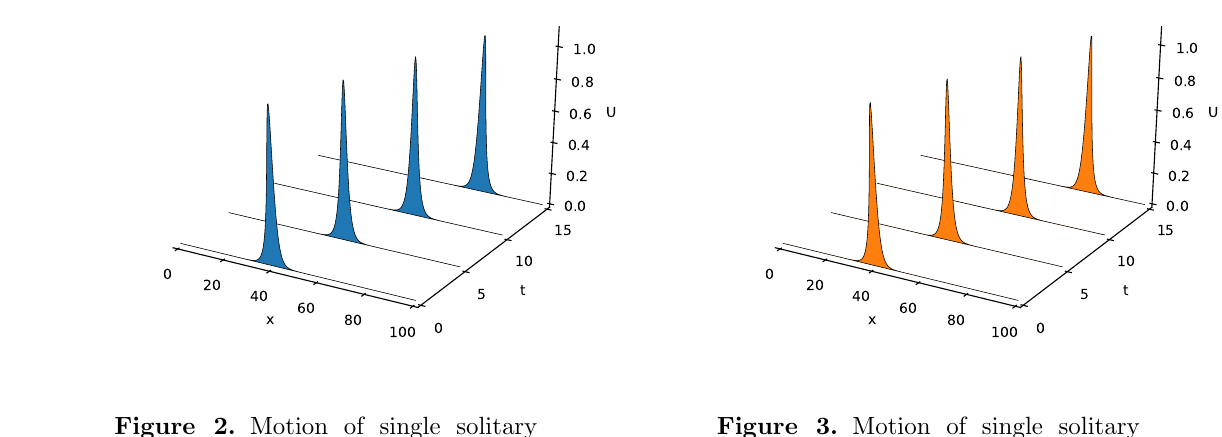
Figure 2. Motion of single solitary wave at t = 0 , 5 , 10 , 15 for N = 400 , ∆ t = 0 . 05 and p = 3. Table 9. Comparison of the results for p = 2, c 1 = 4, c 2 = 1, x 1 = 25, x 2 = 55, ∆ t = 0 . 025, µ = 1 on 0 ≤ x ≤ 250 at different final